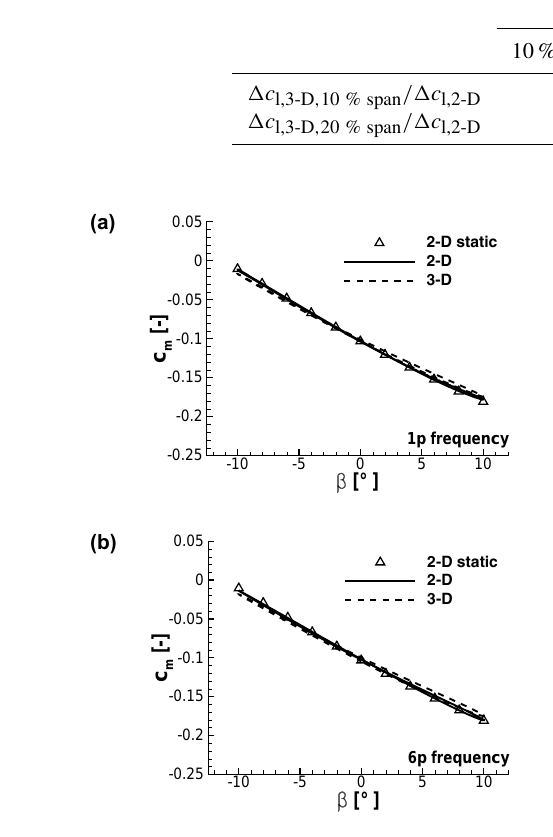
Figure 21. Comparison of 2-D/3-D moment coefficient for differ- ent flap frequencies: 1p (a) and 6p (b)